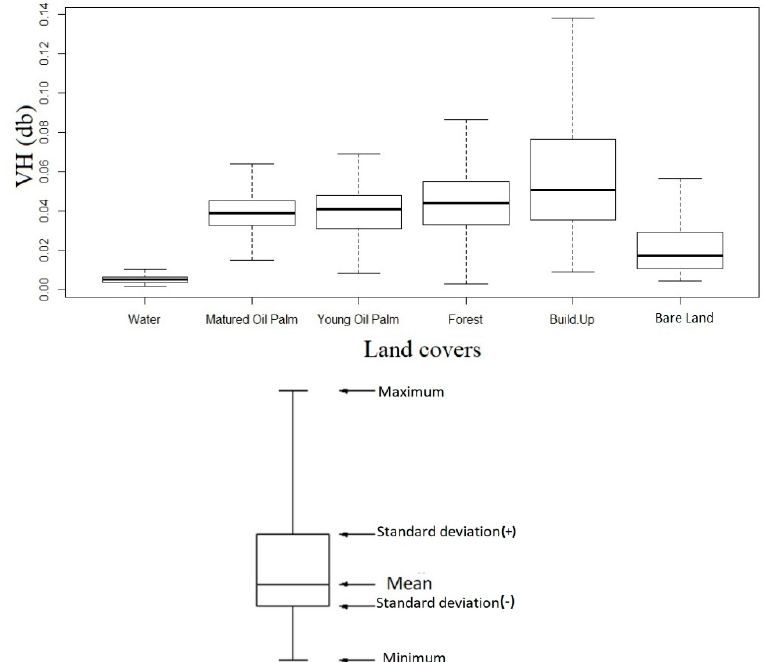
( e ) Boxplot showing the average values of Sentinel 1 VH band for each land cover (ANOVA- p = 0, F value = 246). Figure 4. Boxplots showing land cover type with value from satellite image. Figure 4. Boxplots showing land cover type with value from satellite